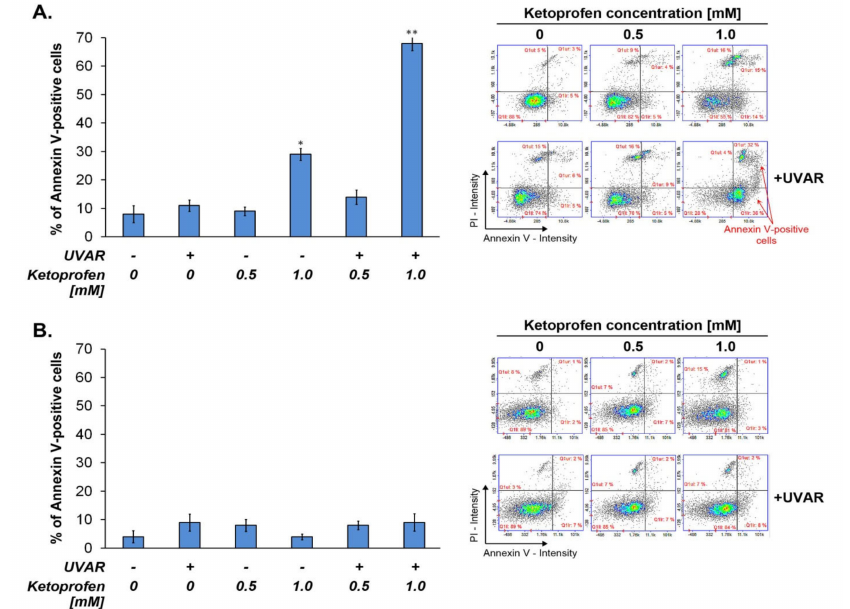
Figure 2. The annexin V/propidium iodide assays of ( A ) human melanoma cells COLO829 and ( B ) human melanocytes HEMn-DP exposed to KTP and UVAR are presented. Bar graphic represents mean values of the percentage of apoptotic cells and corresponding SD. * p < 0.05; ** p < 0.001 vs. control (one-way ANOVA, two-way ANOVA, Tukey’s